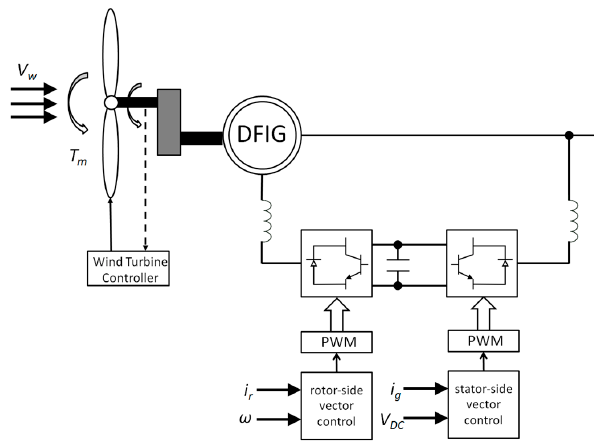
Figure 8. Doubly fed induction generator schematic.